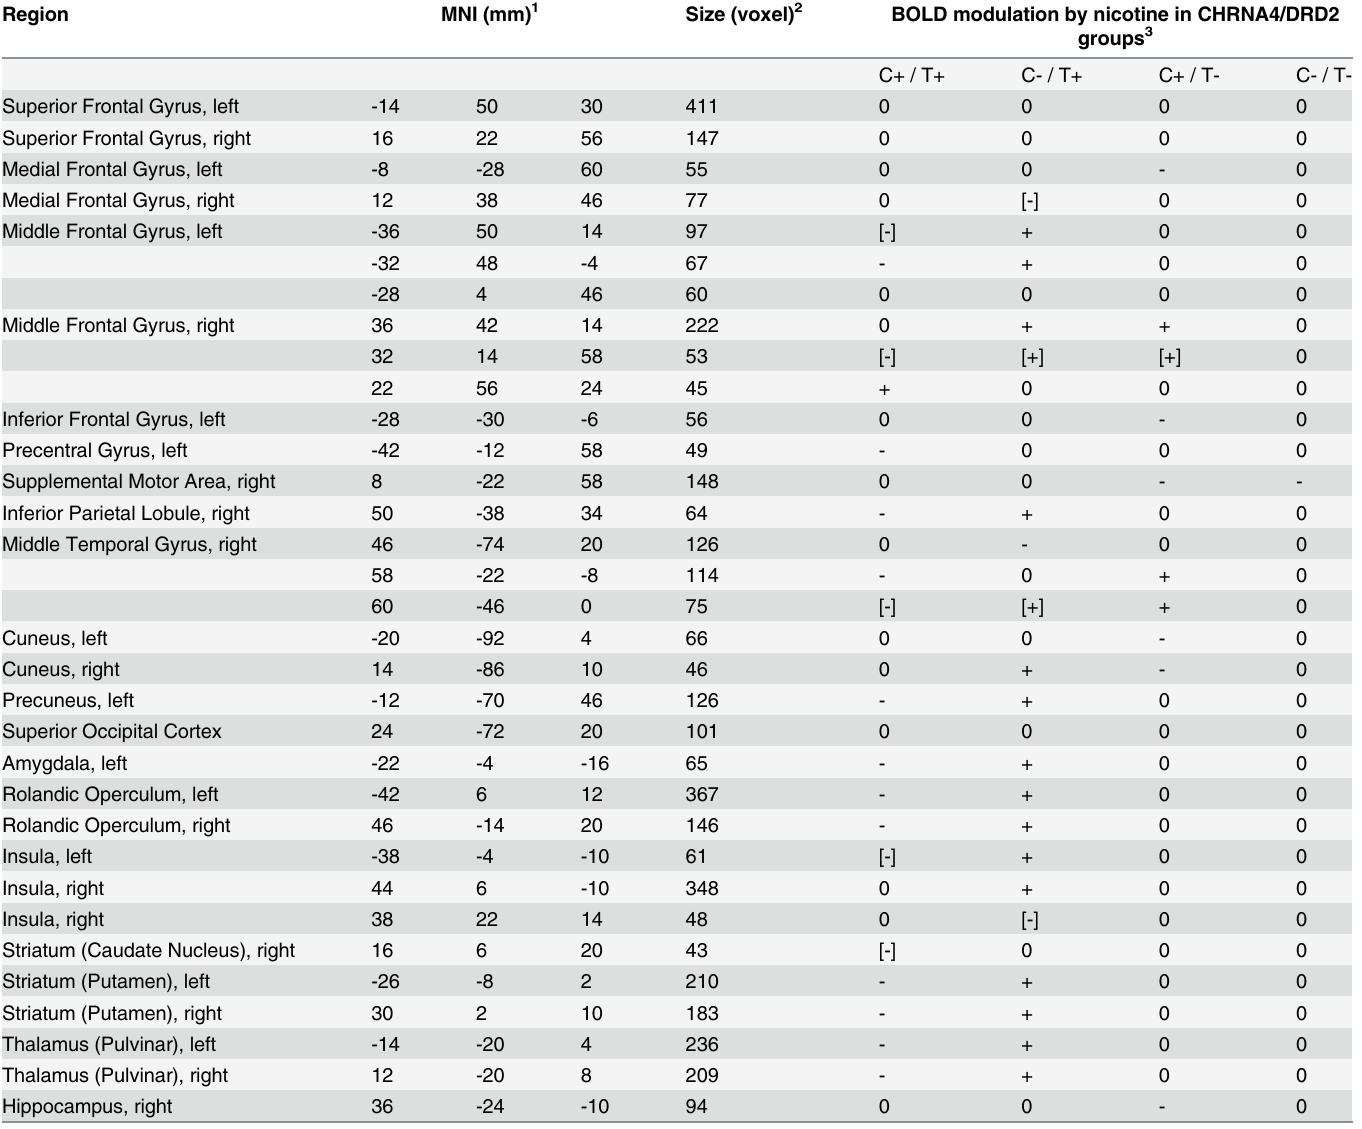
Table 1. Identified brain regions contributing to genotype